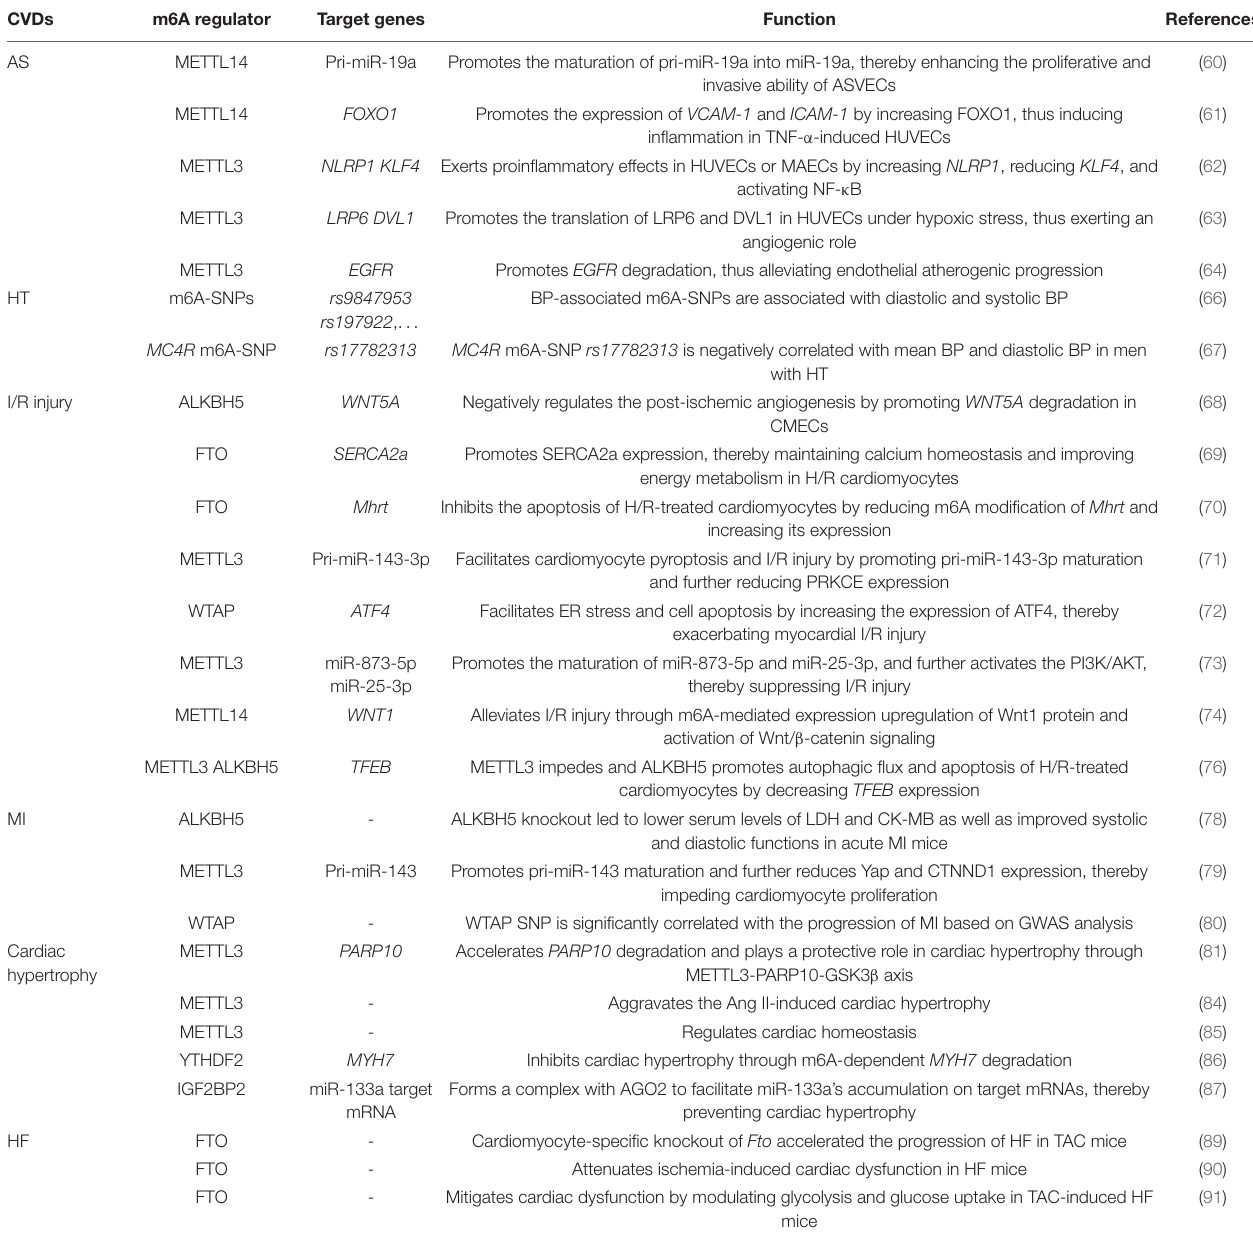
TABLE 1 | The roles of m6A in cardiovascular